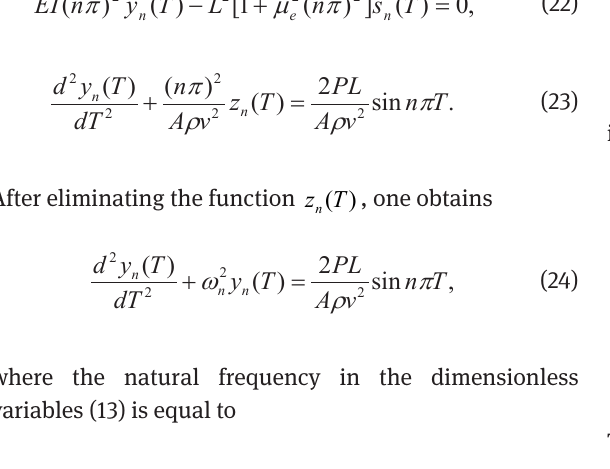
is fulfilled, solutions (29)–(32) tend to